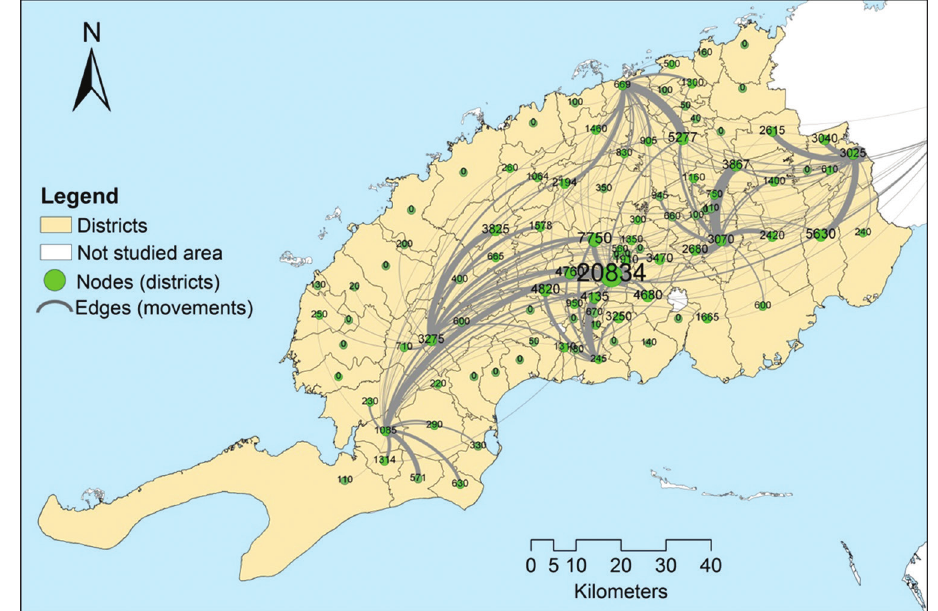
Figure-1: Spatial location of the pig movement network (numbers in green nodes represent the in-degree value).